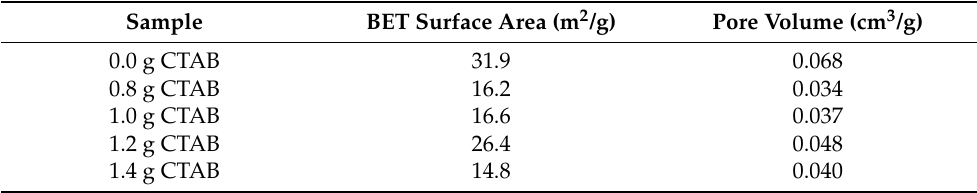
Figure 5. ( a – d ) N 2 adsorption and desorption and (inset) pore size distribution curves of all samples. Table 2. BET surface area and pore volume of all samples.